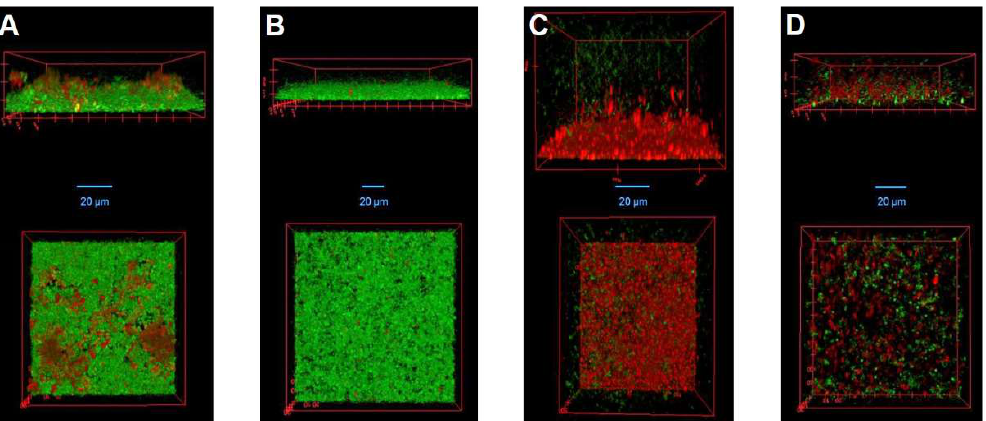
Figure 5. Confocal laser scanning micrographs of S. aureus biofilms treated with DA7, LysK, or a combination of both agents. SA113 biofilms were grown in IBIDI µ-slides for 20 h at 19 °C and then treated for 2 h with: buffer ( A ); 0.625 nM DA7 ( B ); 1.25 µM LysK ( C ); or a combination of 0.156 nM DA7 and 0.938 µM LysK ( D ). Residual biofilms after treatment were stained with LIVE/DEAD stain and then visualized by CLSM. Side views ( top ); and top views ( bottom ) of biofilm 3D reconstructions